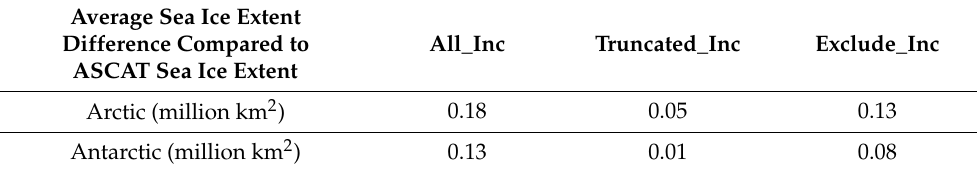
Table 1. Sea ice extent year-long average difference between ASCAT and all_inc, truncated_inc and exclude_inc, respectively, in the Arctic and Antarctic (during the sea-ice GMF construction, all_inc: all the sea-ice backscatter values are included; truncated_inc: sea-ice backscatter values below − 10 dB are not considered at incidence 28 ◦ and 50 ◦ ; exclude_inc: sea-ice backscatter values at incidence 50 ◦ are